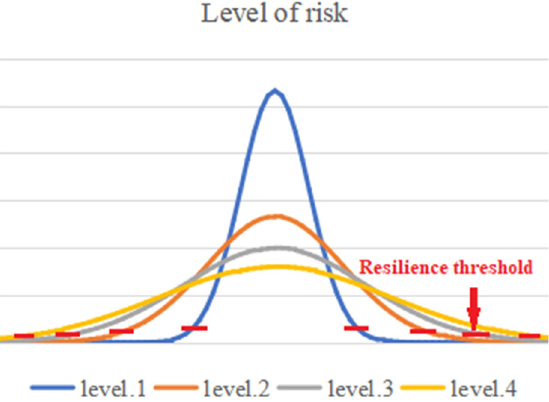
Figure 3. Schematic diagram of resilience thresholds for different risk levels.